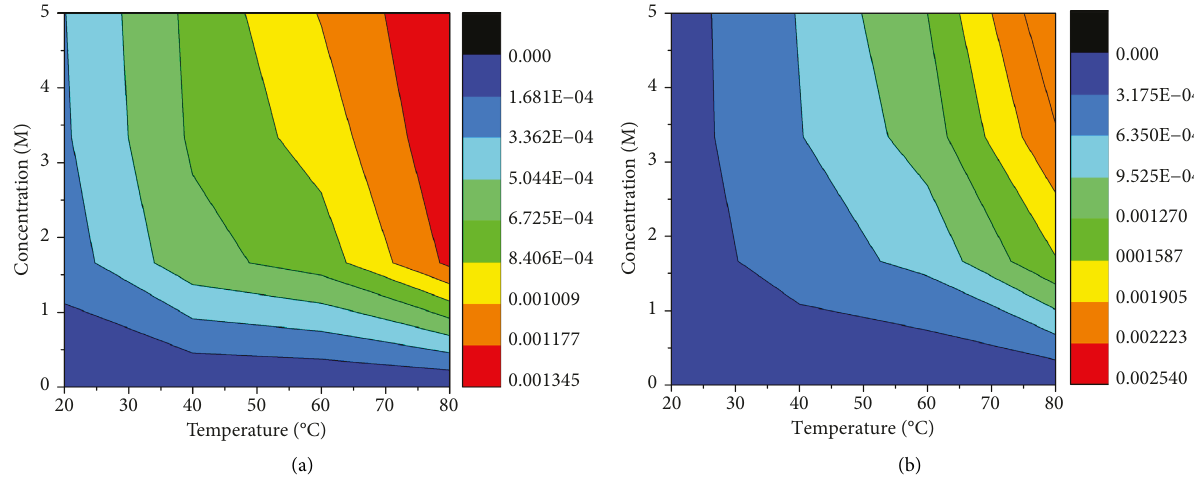
Figure 10: The distribution of ADC of Ca 2+ and Sr 2+ in fly ash/cement waste forms at simultaneous effect: (a) Ca 2+ ; (b) Sr 2+ .